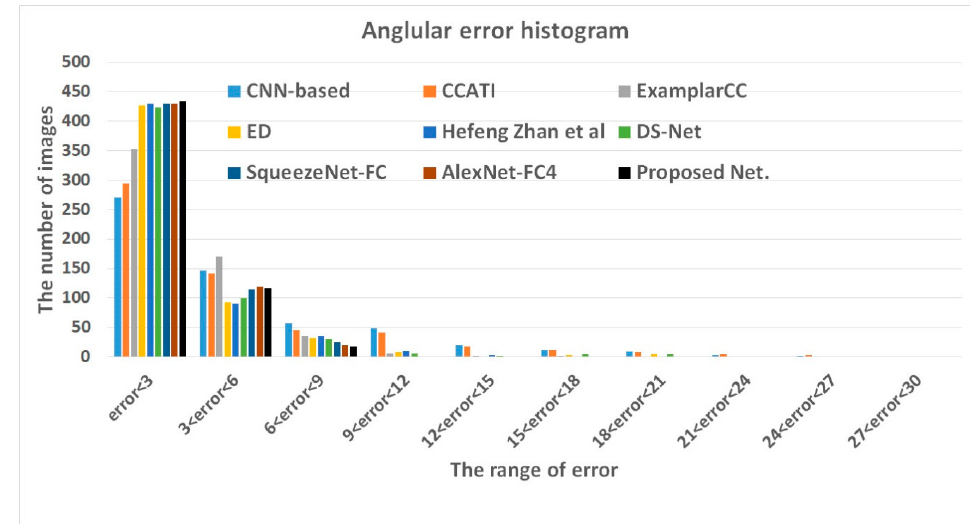
Figure 6. Comparative angular error (AE) histogram of convolutional neural network (CNN)-based, exemplar-based, ensemble of decision (ED) tree based methods, DS-Net, AlexNet-FC, SqueezeNet-FC, CCATI, Zhan et al., and the proposed network (proposed net.) with Shi’s re-processed dataset and the NUS 8-Camera Dataset.